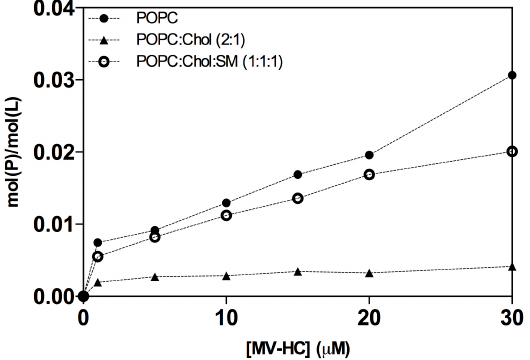
Figure 3. Average peptide-to-lipid ratios (mol(P)/mol(L)). The ratios were calculated using the sensorgrams’ maximum binding response, as a function of peptide concentration, for its interaction with deposited POPC (solid circles), POPC:Chol (2:1) (solid triangle) and POPC:Chol:SM (1:1:1) (open circle) SUV. Peptide binding and SUV capture response values were retrieved from individual sensorgrams at specific reporting time points. Molar ratio values were calculated based on the relationship 1 RU to 1 pg/mm 2 of bound peptide or lipid [65].